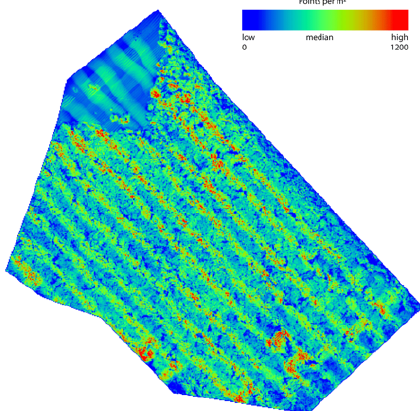
Figure 7: Plot of LiDAR point densities (points/m 2 ). Figure 7 Error! Reference source not found. plots the point densities of the point cloud across the study area. In this visualisation, each pixel is 1m 2 and the densities shown represent the number of LiDAR points at each vertical column. The total number of pixels/samples/m 2 is n=127,706. The diagonal striations reflect the flight path of the airborne LiDAR acquisition unit; the heavier densities are the result of matter receiving two passes of the scanner from a return path, and the lighter areas have only been revealed by one pass. Figure 8 shows the distribution of the point density classes. The most frequent class 300–400 points/m 2 (Figure 8). This suggests the point density within each cell is sufficient for modelling and analysis.